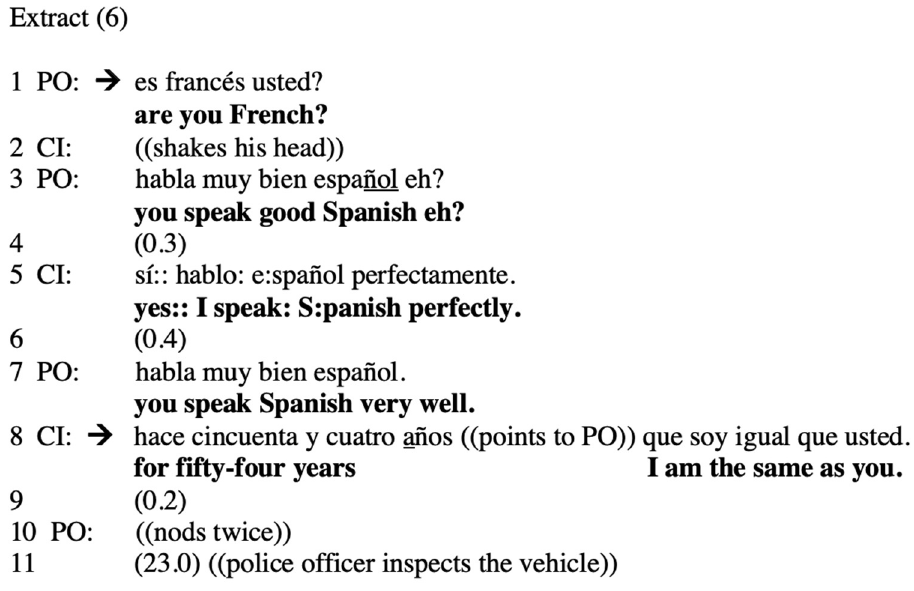
Figure 9. Extract